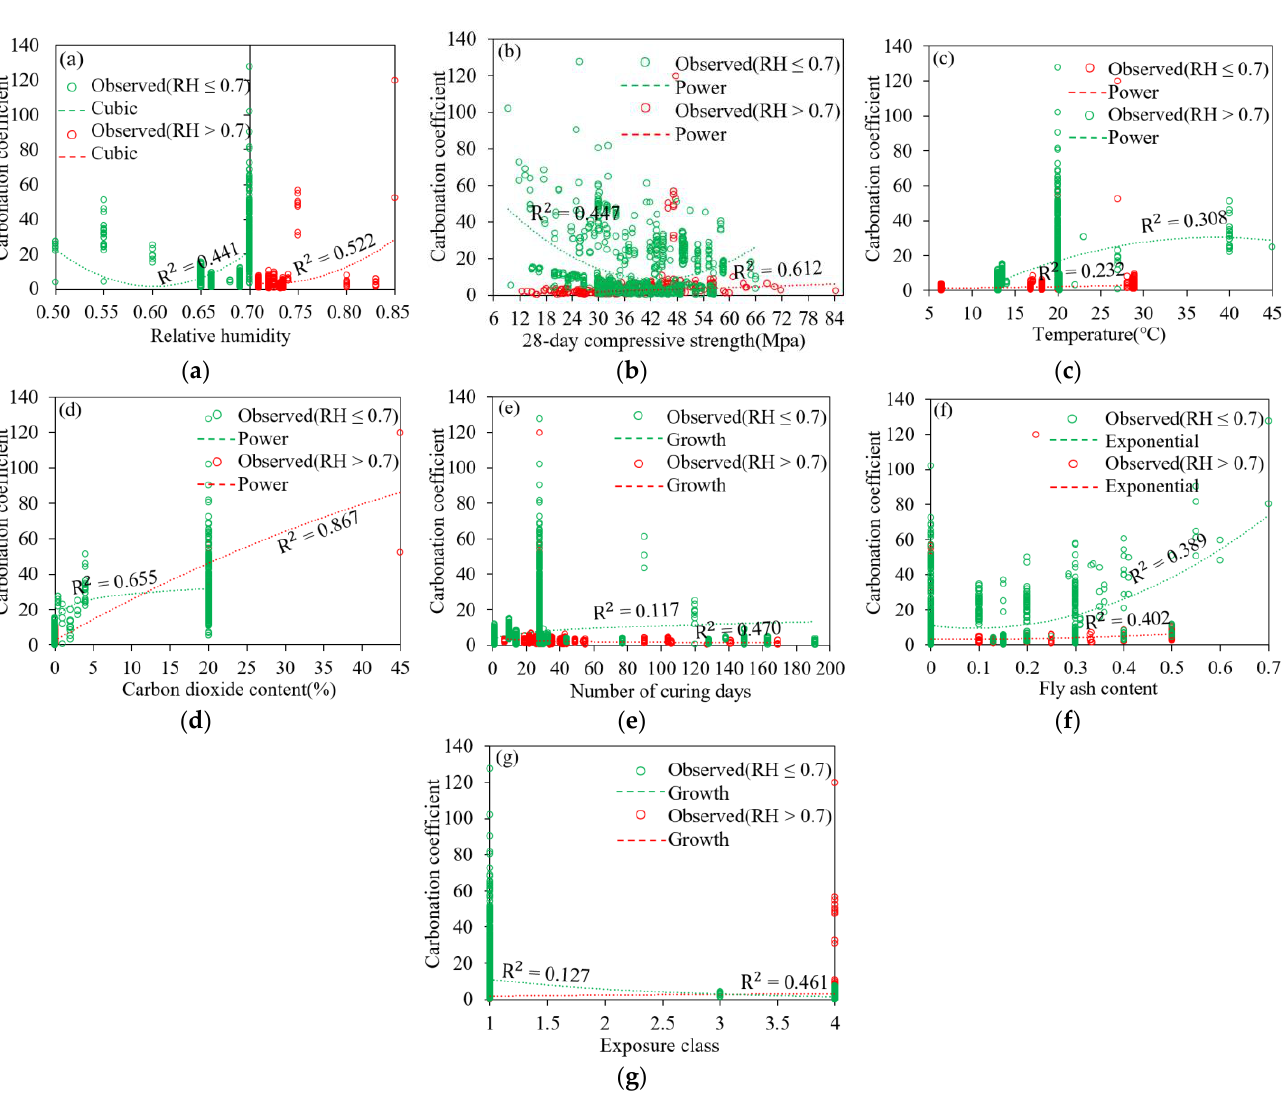
Figure 1. Correlation between each parameter and carbonation coefficient ( a – g ) are the maximum curve estimation of RH , f c , T , C , D , FA and X and carbonation coefficient